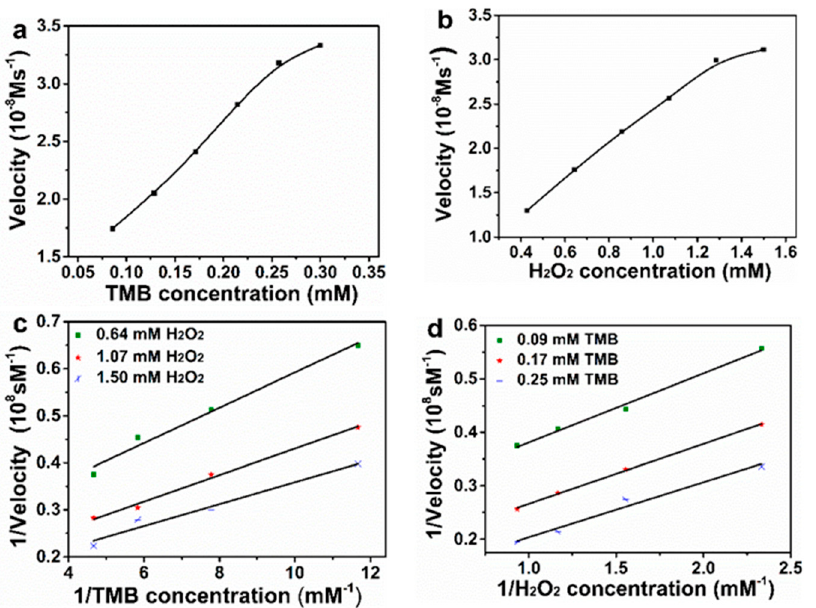
Figure 8. Steady-state kinetic assay and catalytic mechanism of Pt 600 -GLP NCs: ( a ) The H 2 O 2 was 1.07 mM with varying TMB concentration. ( b ) The TMB was 0.17 mM with varying H 2 O 2 concentration. ( c , d ) Double reciprocal plots of activity of Pt 600 -GLP NCs with the concentration of one substrate (H 2 O 2 or TMB) fixed and the other varied.